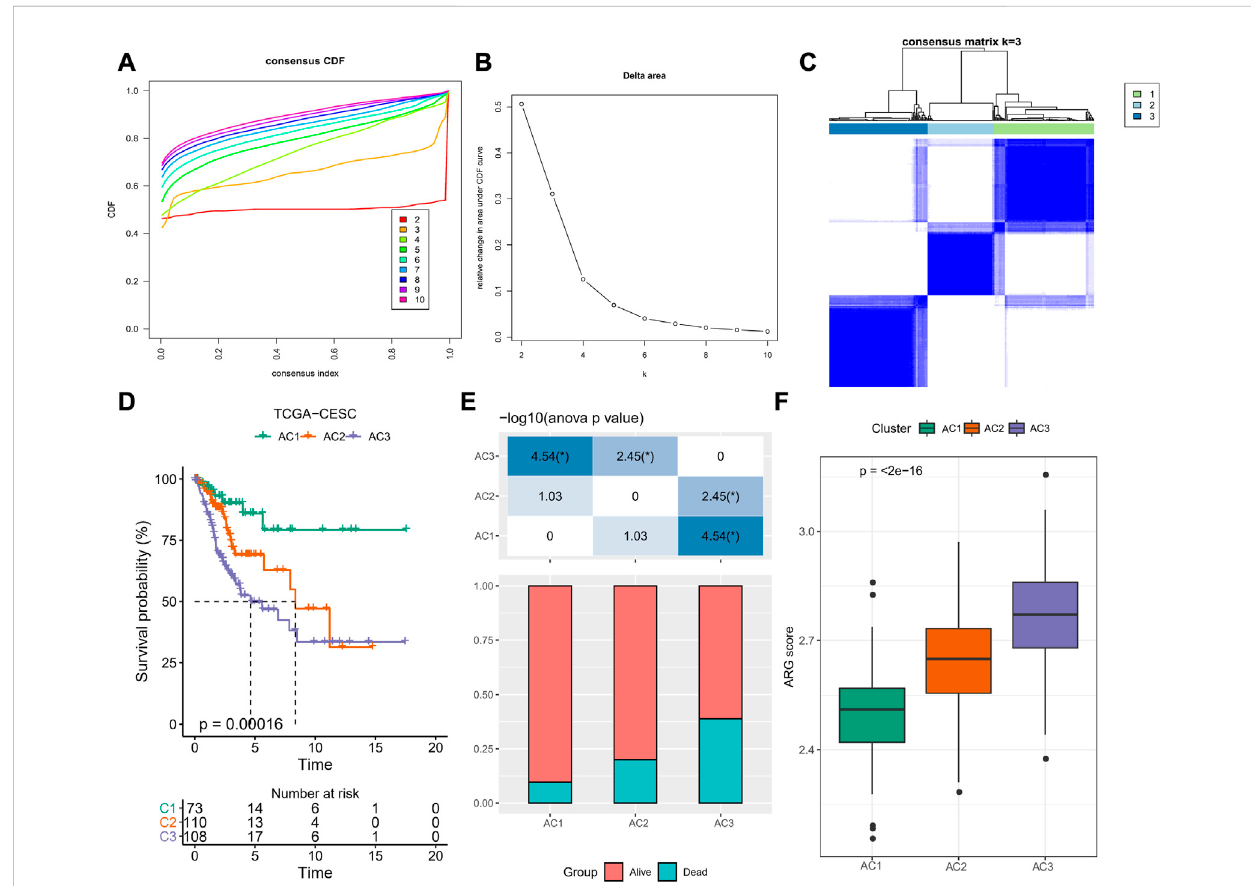
FIGURE 3 ARLs-relatedmolecularsubtypesinTCGA-CESC. (A) Cumulativedistributionfunction(CDF)ofconsensusclustering (B) CDFDeltaareacurvefor k = 2 – 10 (C) Heatmapofsampleclustersshowsconsensusmatrix k =3 (D) K-McurvesofAC1-3patientsinTCGA-CESC (E) Statisticalgraphofpatientsurvival status for patients in AC1-3 (F) Distribution of ARG score amongst clusters AC1-3. * p <